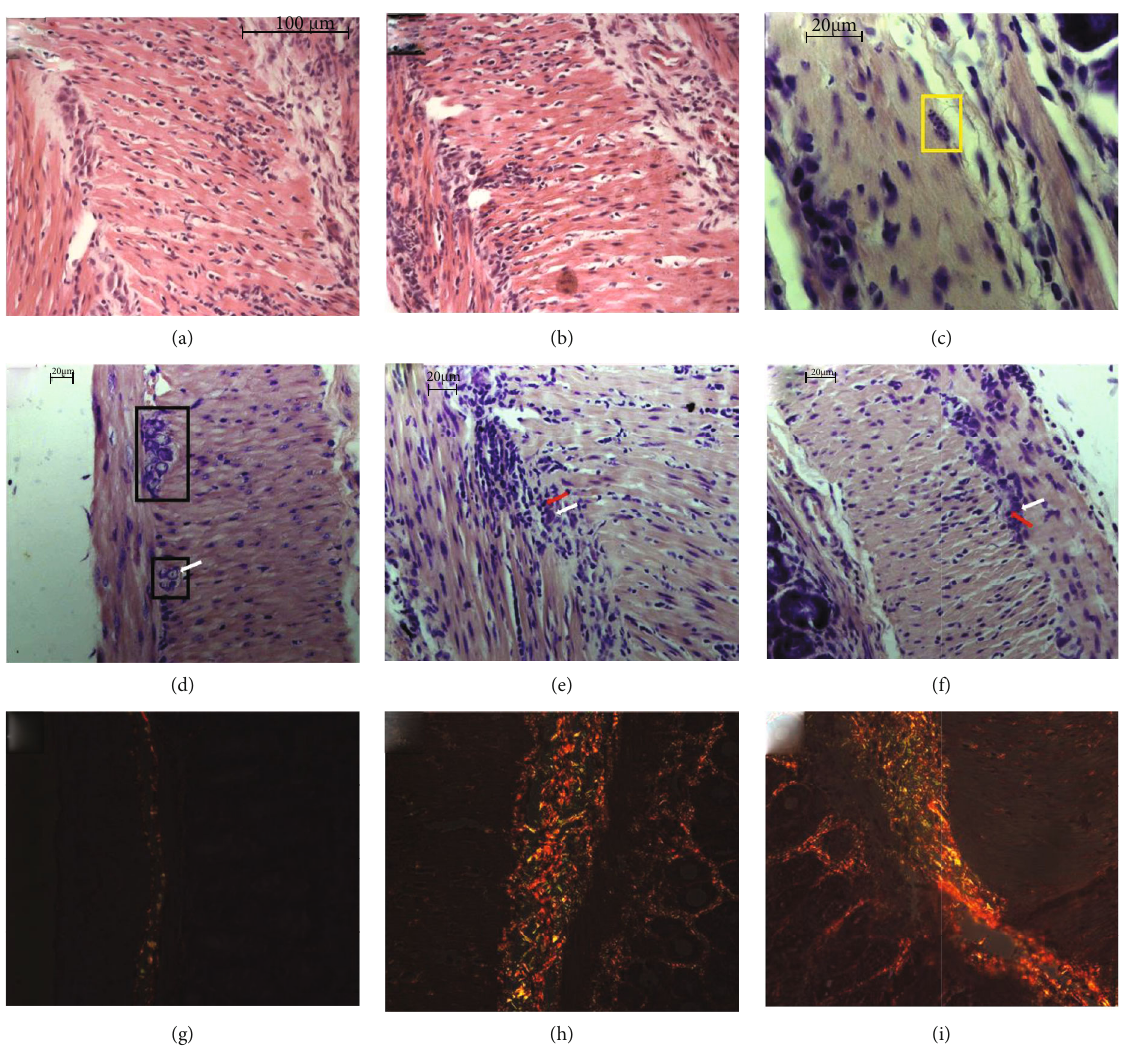
Figure 3: Intestinal photomicrographs of the intestinal histopathological di ff erences between the noninfected, acute, and early chronic phases of T. cruzi Colombian strain infected C57Bl/6 mice. Intestinal in fl ammatory in fi ltrate (HE): (a) acute phase and (b) early chronic phase. (c) Intestinal amastigote nest in the acute phase highlighted by yellow lines (GIEMSA). Intestinal nerve ganglia (GIEMSA): (d) the two intestinal nerve ganglia of the myenteric plexus of uninfected mice highlighted using black lines (30 days); nervous ganglion without borderline of infected mice in the (e) acute and (f) early chronic phase with neuron (white arrow) and in fl ammatory cells (red arrow) remarkably close. Intestinal collagen deposition (Picrosirius): (g) noninfected, (h) acute, and (i) early chronic phase of